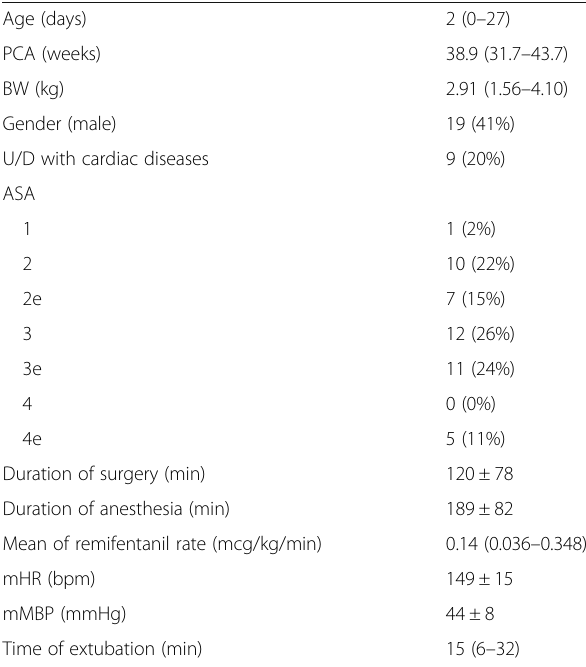
Table 2 Neonatal cases given remifentanil infusion during